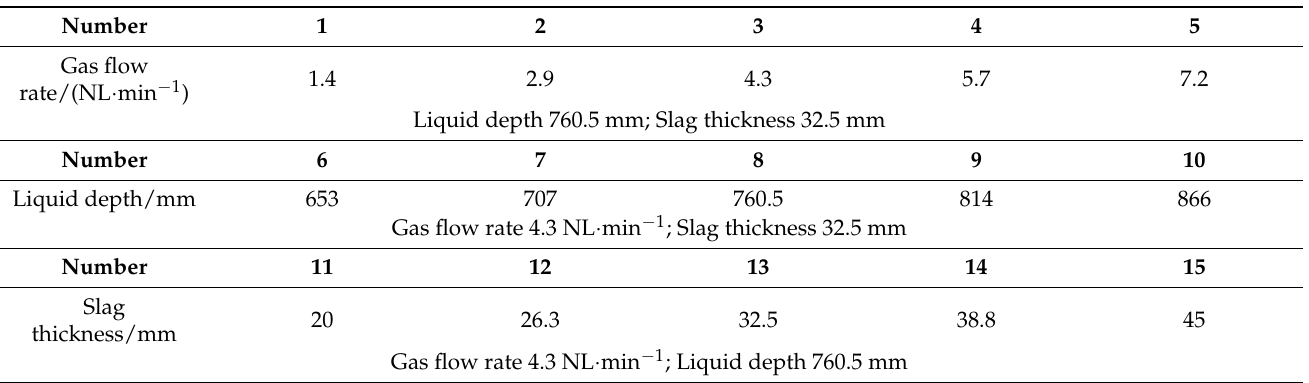
Table 5. Experiment scheme of single factor analysis.